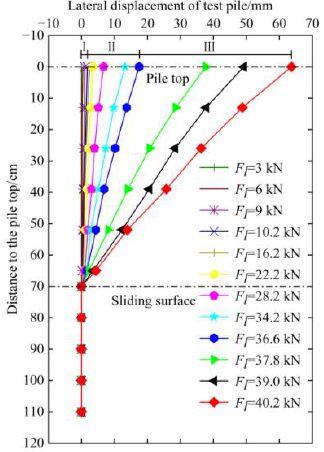
Figure 11. Displacement distributions along the test pile.